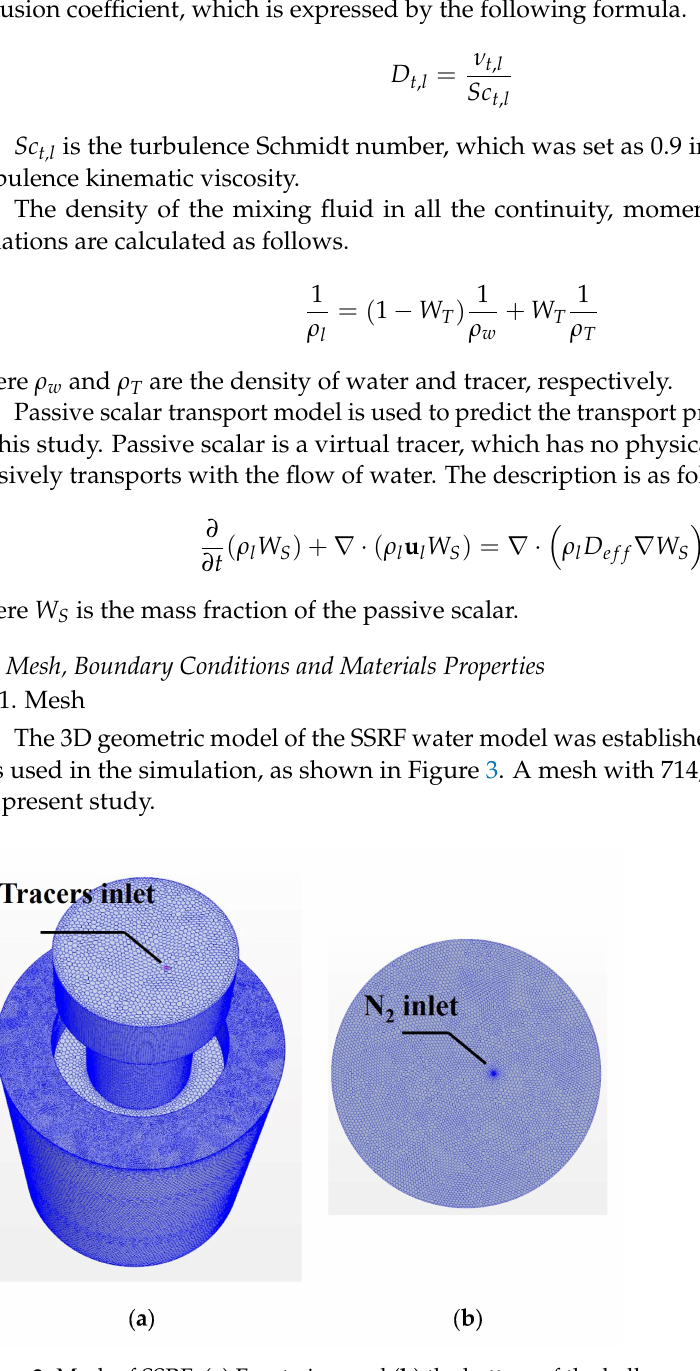
Figure 3. Mesh of SSRF: ( a ) Front view and ( b ) the bottom of the